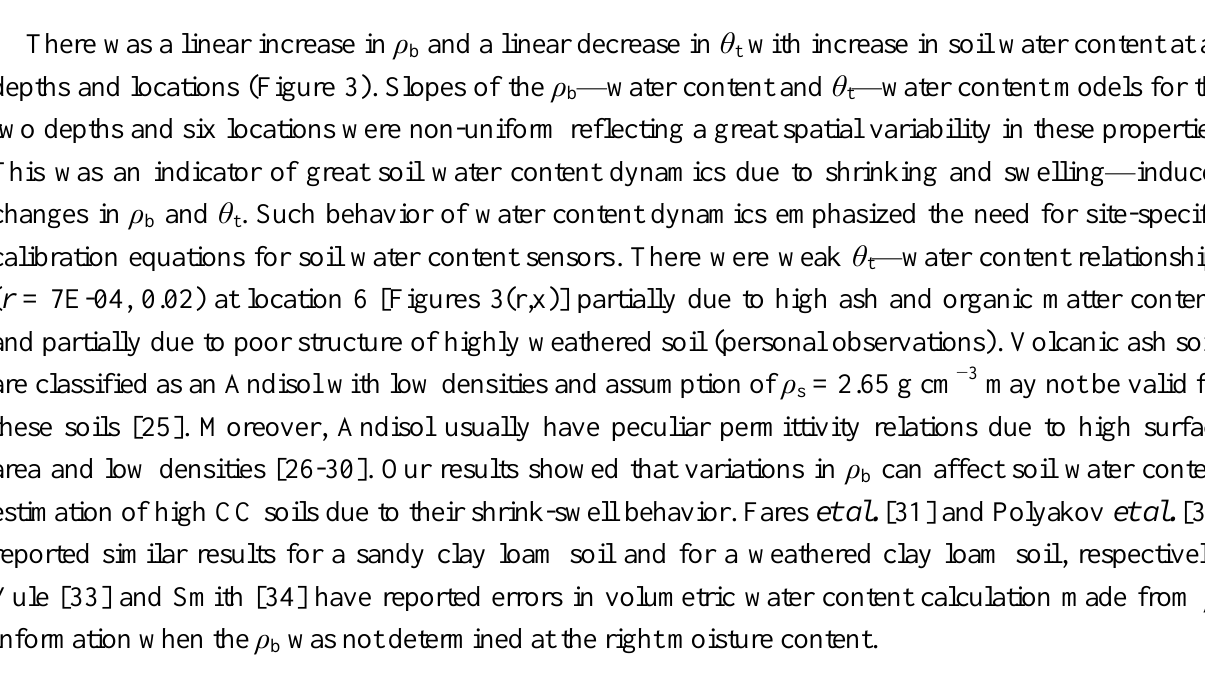
= 1 − ρ / ρ , where θ is total porosity, ρ t b s t